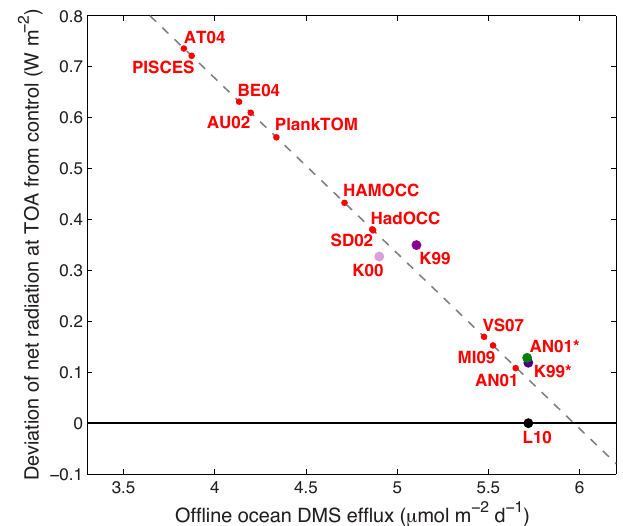
Figure 5. Change in global- and annual-mean net radiation at the top of the atmosphere between model experiments and control ex- periment relative to the global- and annual-mean flux of ocean DMS. Crosses represent the ensemble means of simulations with unmodified DMS fields. Open circles denote ensemble mean of sim- ulations with seasonality (red) or spatial pattern (yellow) removed. Open diamonds denote simulations with DMS fields different from L10 but scaled to give the same global-mean flux. Individual en- semble members for each experiment are shown as dots of the same colour. Only data from individual runs with unmodified K99 (pur- ple) or L10 (blue) DMS emissions are used for the corresponding regression lines.